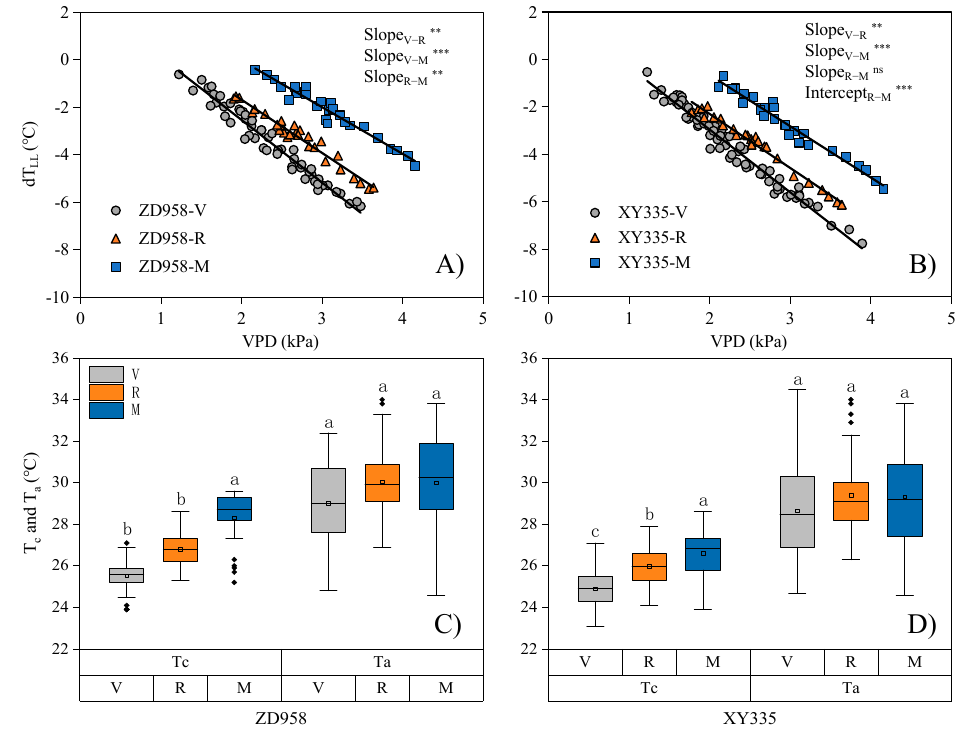
Figure 3. The relationships between lower limit of canopy-air temperature difference (dT LL ) and vapor pressure deficit (VPD) during the late vegetative (V), reproductive (R), and maturation stages (M) for two maize genotypes, ( A ) ZD958 and ( B ) XY335, respectively. Average canopy (T c ) and air temperature (T a ) are presented during the V, R, and M stages for ( C ) ZD958 and ( D ) XY335, respectively. The slopes and intercepts among the three growth stages are compared by the ANCOVA test for ( A ) ZD958 and ( B ) XY335, respectively. For the box plot, the lower and upper bounds correspond to the first and third quartiles (interquartile range, IQR), the horizontal lines inside the boxes are the medians, the upper/lower whisker extends from the bound to the largest/smallest value no further than 1.5 × IQR from the bounds, and data beyond the end of the whiskers are plotted individually. The differences of T c and T a among different growth stages were analyzed by one-way ANOVA for ZD958 and XY335, respectively. Different letters denote significant differences ( p < 0.05) by a Tukey’s posthoc test for means comparison. ns, no significant difference; **, p < 0.05; ***, p < 0.001. Table 2. Slope, intercept, and other detailed parameters of non-water-stressed baselines’ (NWSBs) linear fitting reported in this study and previous maize studies.